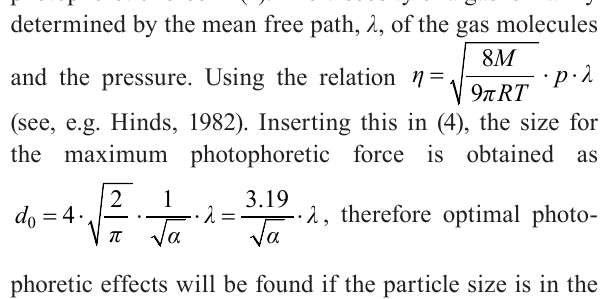
Fig. 5 Experimentally determined photophoretic forces as a function of pressure. All data show a maximum photo- phoretic force at an intermediate pressure as postulated by theory. The dark lines are results of model measure- ments with cm-sized spheres in vacuum, the points result from measurements made with individual micro- or nanometer-sized particles consisting of various materials, the gray line is theory